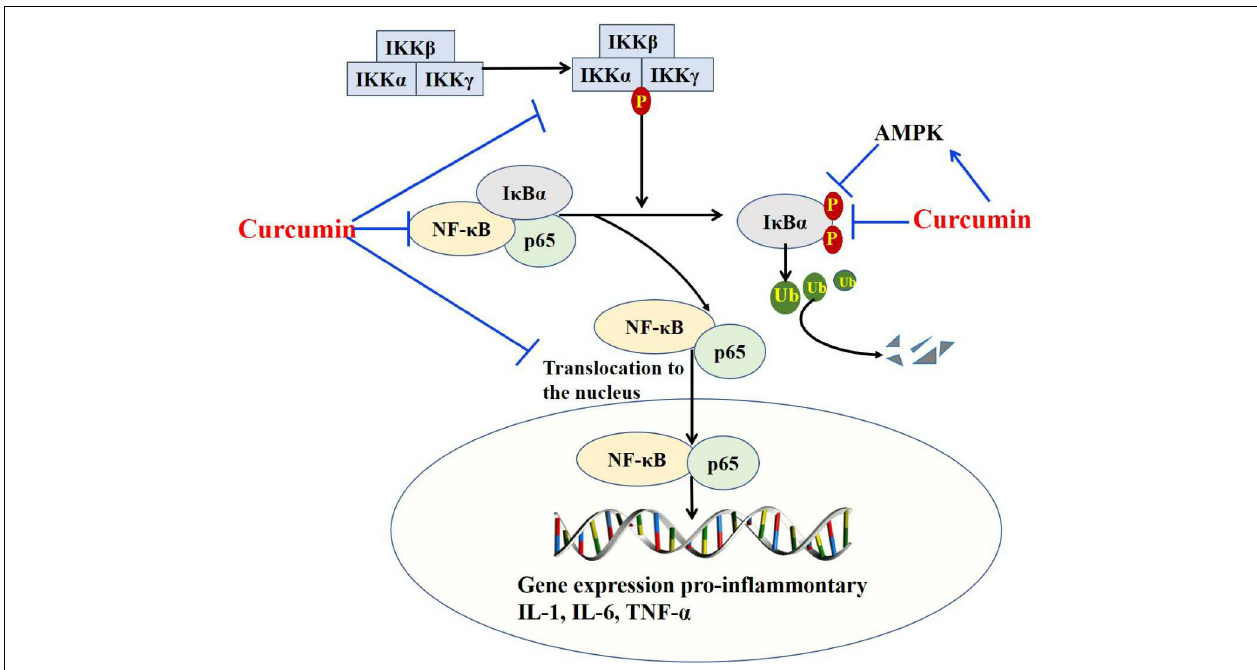
FIGURE 2 | Curcumin inhibits the production of pro-inflammatory cytokine by targeting the NF- κ B pathway. Curcumin targets NF- κ B signaling through inhibiting activation of IKK β , enhancing expression or stability of I κ B α , activating AMPK, and targeting